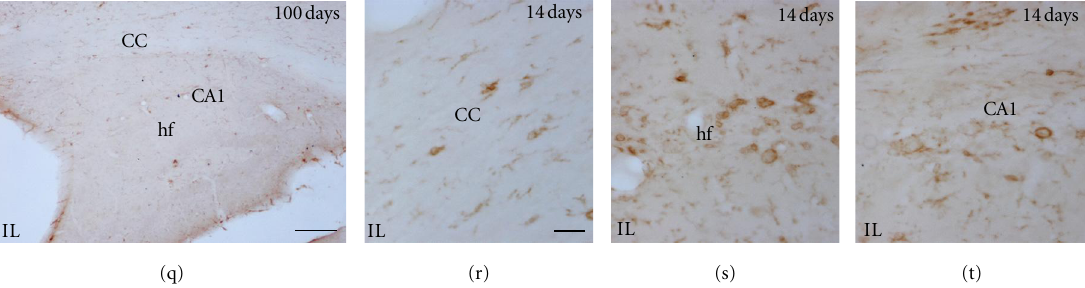
Figure 9: Iba-1 immunostaining showing age-matched controls and H/I e ff ects on the hippocampus and corpus callosum. Developmental changes in microglia are observed in control animals (a–c), showing a progressive change from mainly primitive ramified and amoeboid cells (a) to a resting morphology at P14 (b) and P21 (c). Activated microglia increases in the contralateral (CL) (d) and ipsilateral (IL) hemisphere at 3hrs (g). At the CL side, Iba-1 shows the maximum labeling at 24 hrs (e) in the hippocampal fissure, returning to control level at 72hrs (f). In the IL side, higher proportion of amoeboid cells is seen from 24 hrs (h) to 72hrs (j). At 7 days after hypoxia (n), a reduction on the level of microglia morphologically activated is observed, returning to the basal level at 14 days (o). Resting morphology is observed at 30 (p) and 100 days (q). Detailed morphology of Iba-1+ cells in the cc (k), hf (l), and CA1 (m) observed after 48 hrs and 14 days after H/I (r, s and t, resp.) are shown. Scale bars: in low magnifications: (a) to (j) and (n) to (q) = 100 μ m; scale bar in (k, l, m r, s, and t) = 20 μ m. CA1: cornu ammonis 1; hf: hippocampal fissure; CC: corpus